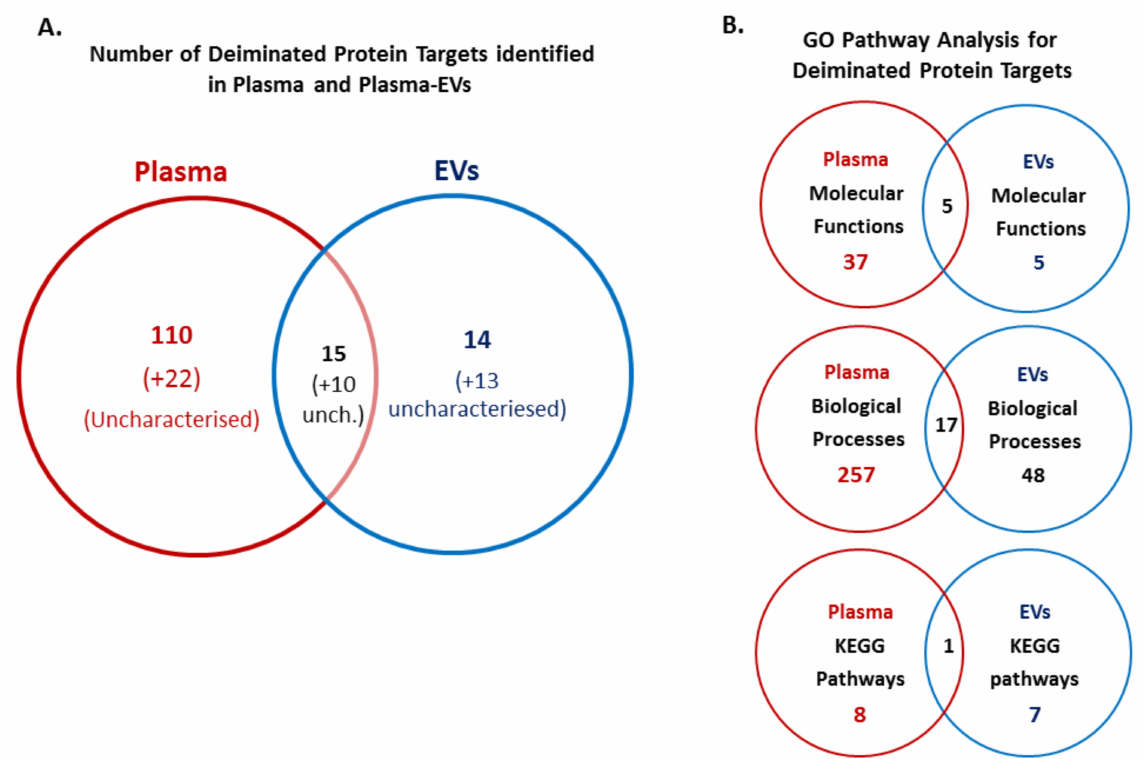
Figure 4. Deiminated protein hits identified in reindeer plasma and plasma EVs. ( A ) Venn diagram showing deiminated protein hits identified in R. tarandus whole plasma and plasma EVs, representing shared and unique proteins hits (un- characterized hits are indicated in brackets). ( B ) Venn diagrams showing GO pathway analysis for deiminated proteins identified in plasma and plasma EVs, respectively. The number of Molecular function pathways, Biological Processes and KEGG pathways, which were found enriched in R. tarandus whole plasma and plasma EVs, respectively, as well as shared pathways between whole plasma and plasma EVs, are